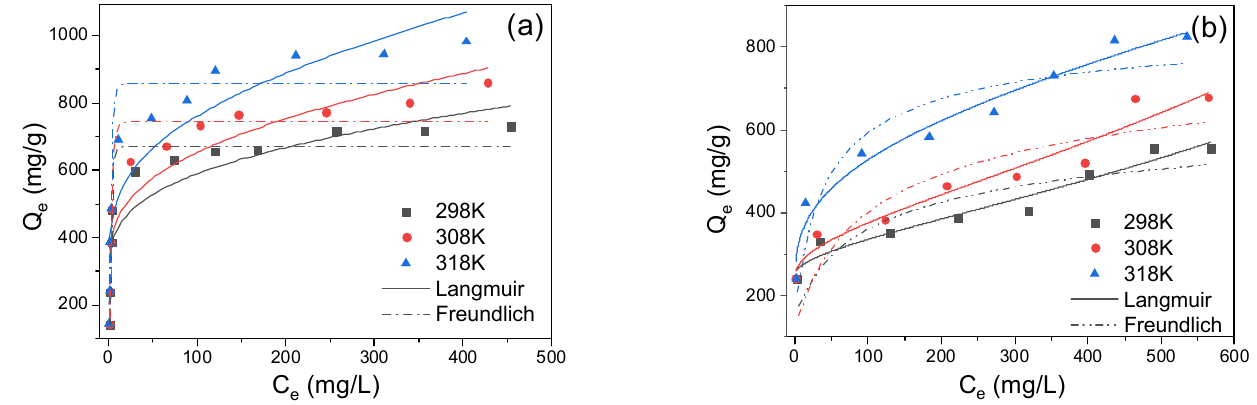
Figure 4. Langmuir and Freundlich isotherm models for Cr(VI) adsorption onto APNs ( a ) and PAN/APNs ( b ) (pH = 2, adsorbent dose = 0.2 g/L). Table 1. The Q m values of APNs, PAN/APNs and other reported adsorbents.